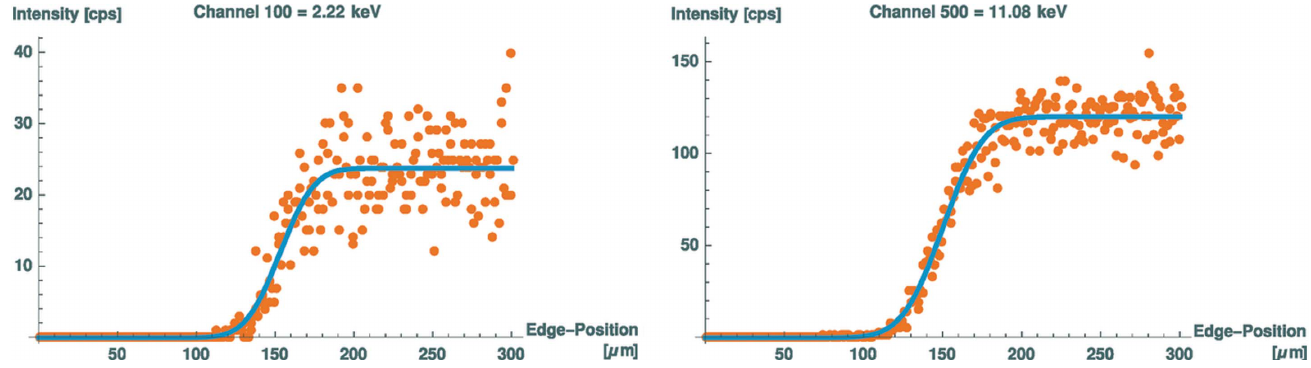
Figure 4 Knife-edge scans for different channels (horizontal). As shown for channel 100 on the left, channels in the low- and high-energy range do not give a statistically relevant signal suitable for evaluation. Channels between 6.2 keVand 18.0 keV, such as channel 500 shown as an example on the right, are suitable for a channel-wise